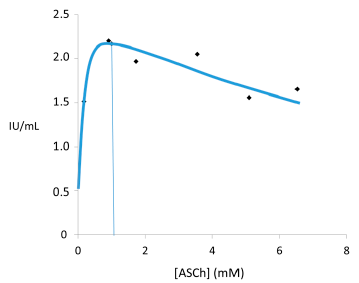
Figure 1. Bell-shape curve of enzymatic hydrolysis of hydrolysis of acetylthiocholine (ASCh) by AChE purified from human erythrocytes indicate the inhibition of the reaction by the substrate. Applying the Ellman’s method, AChE 0.04 IU/mL was added to preincubated for 10 min, at 25 ◦ C, in 1 mL assay solutions with 100 mM PO 4 buffer, pH 8.0, and 0.2 mM DTNB [5,5-dithiobis(2-nitrobenzoic acid)] before adding the substrate at 0.0025 to 6 mM final concentrations. All experiments were repeated three times, and similar results were obtained. All the values obtained above 1 mM of ASCh were diminished with those obtained in non-enzymatic hydrolysis. All data were analyzed applying the least square method to the velocity equation coupled with the iterative non-linear method